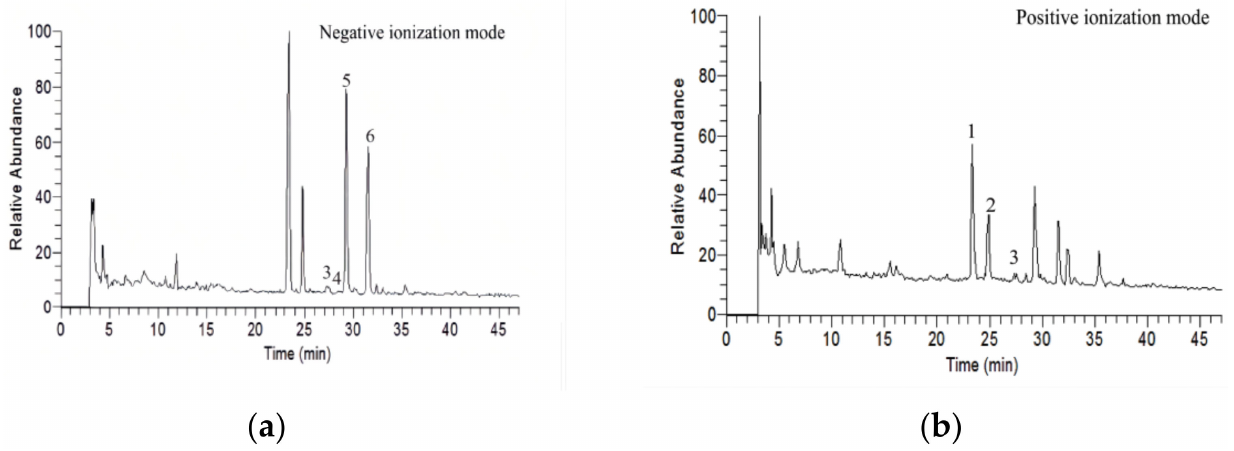
Figure 1. TIC chromatogram of flavonoids composition from the extracts of okra. ( a ) Negative ionization mode. ( b ) Positive ionization mode.